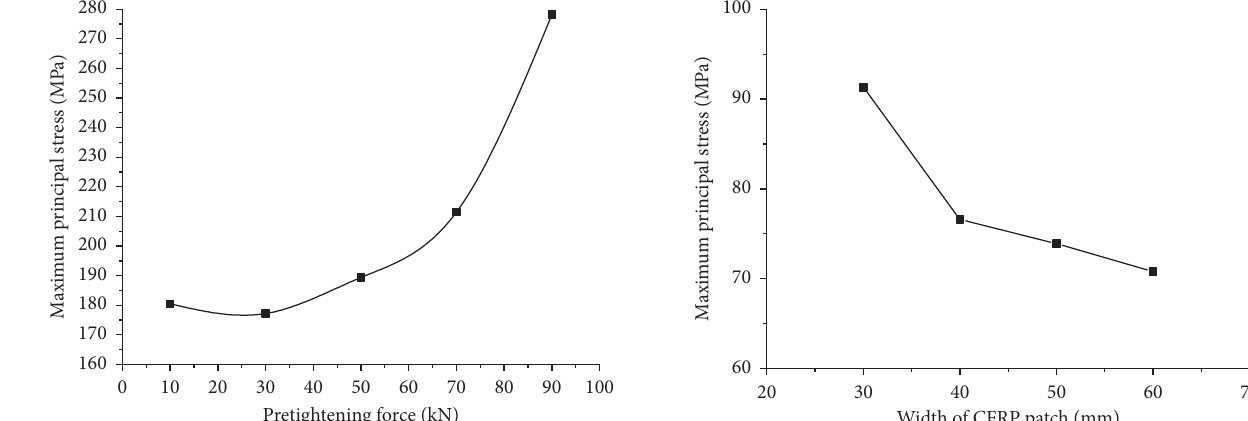
Figure 10: Maximum principal stress of different CFRP